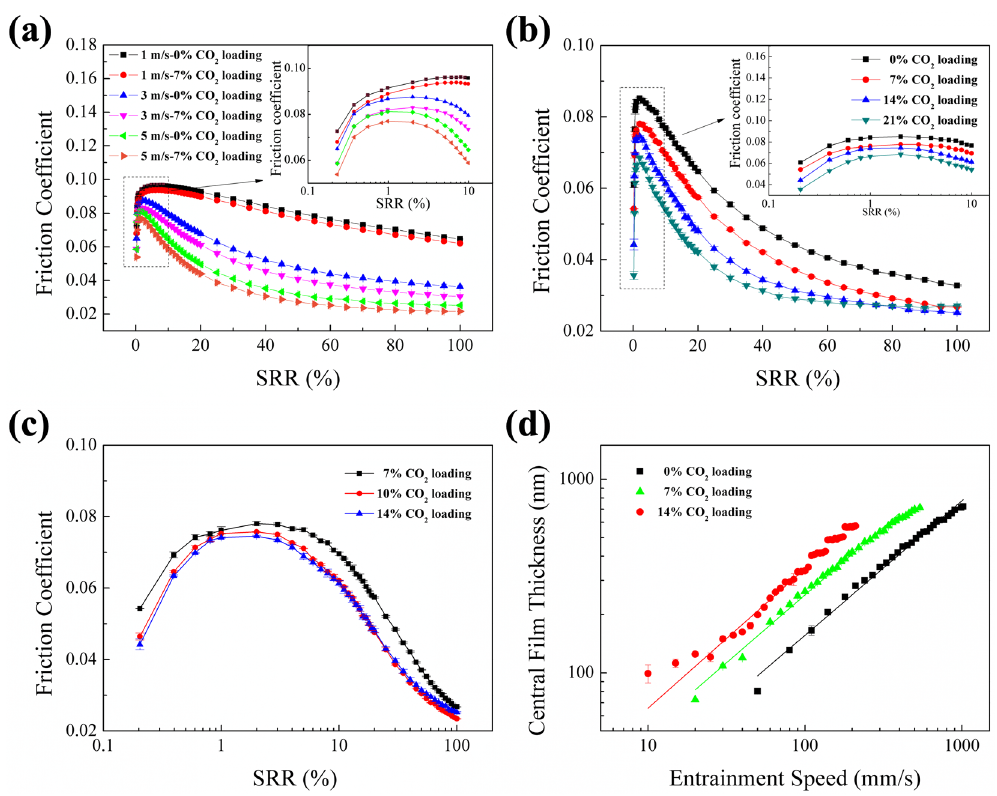
Figure 4. ( a ) Friction coefficients as function of SRR and entraining velocity at a contact pressure of 1.35 GPa; ( b ) Friction coefficients at an entrainment speed of 3 m/s and a contact pressure of 1.35 GPa for liquids with different CO 2 loading as function of SRR; ( c ) Friction coefficients at an entrainment speed of 3 m/s and a contact pressure of 1.35 GPa for liquids with different CO 2 loading at low SRR; ( d ) Central film thickness as function of entrainment speed in EHL contact for DBU/glycerol/CO 2